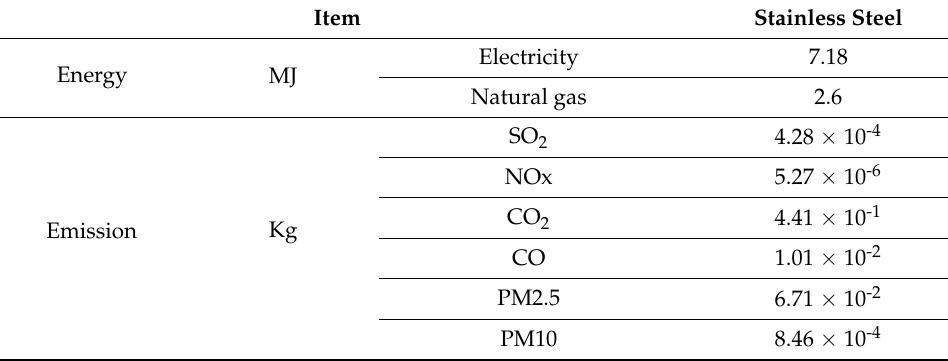
Figure 6. LCA model for scrapping phase of scrubber system. Table 3. The energy consumption and emissions from recycling process [14].